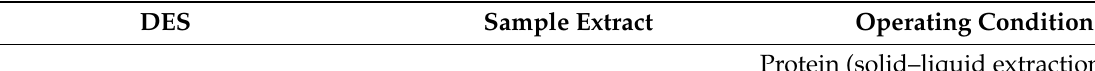
Table 2. Summary of the application of DES in extraction of